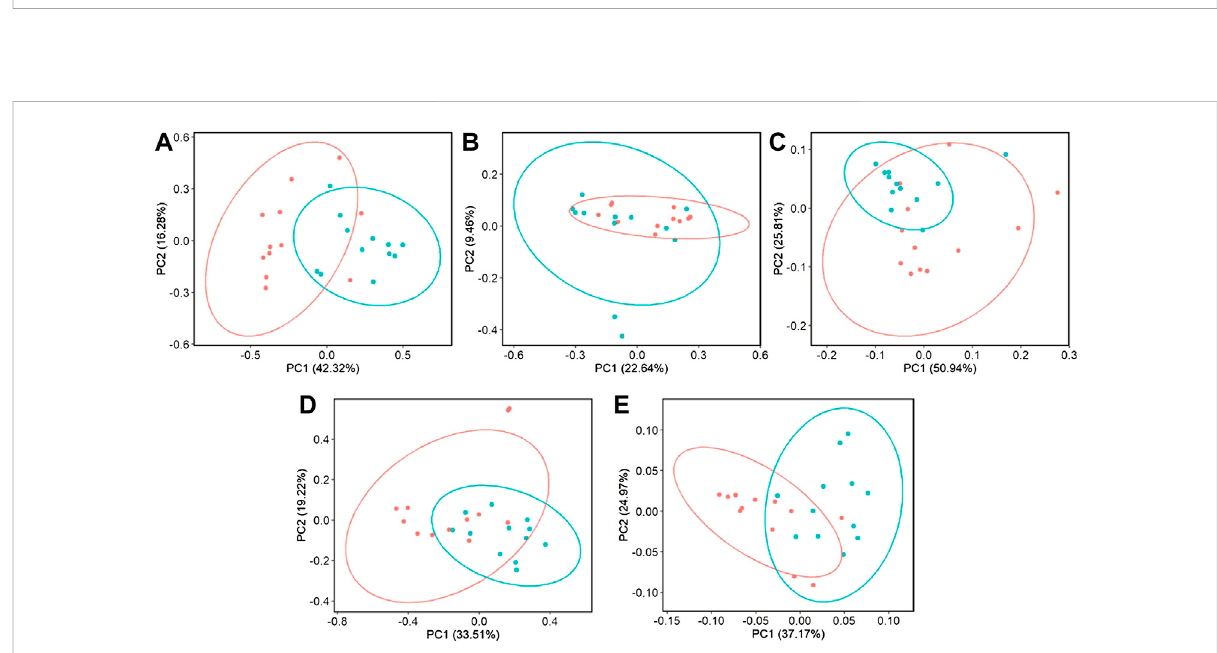
FIGURE 7 The effect of Salmonella challenge on beta diversity measures in the ileum. Signi fi cant dissimilarity was seen in Bray-Curtis (A,D) , unweighted Unifrac (B) , and weighted Unifrac (C,E) for 21 (A – C) and 24-day-old (D,E) broilers. Red represents control (C) broilers while blue represents Salmonella Typhimurium challenged (ST)